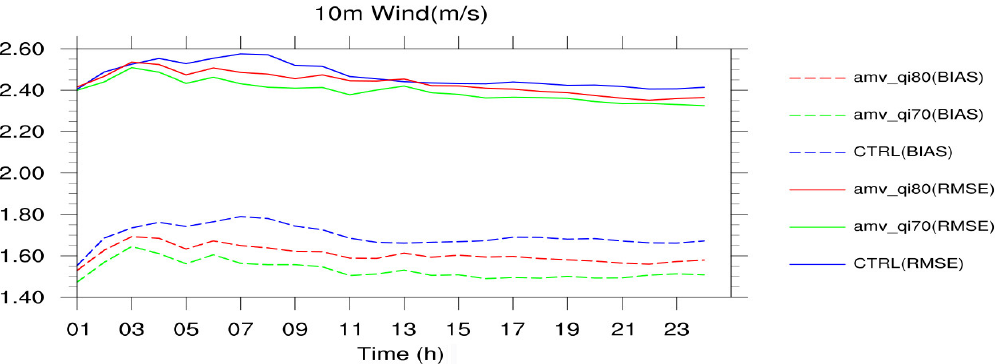
Figure 8. The bias and RMSE of the forecast wind at 10 m averaged over the 3 km domain from the experiments of the CTRL, amv_qi70 and amv_qi80 in the forecast range of 0–24